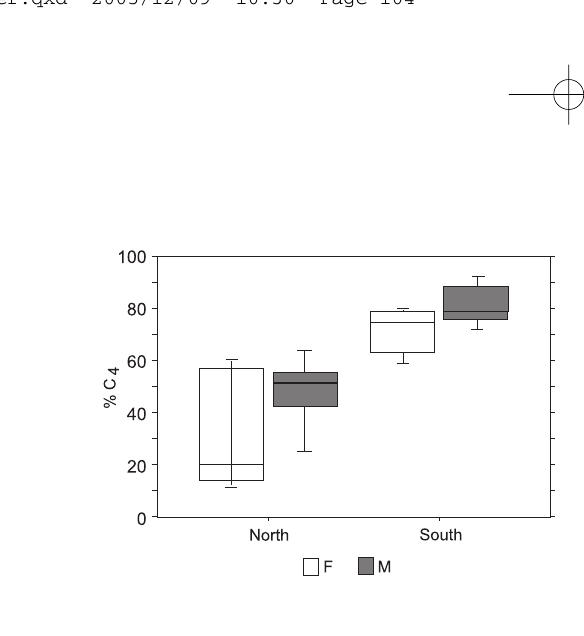
Fig. 3. Boxplot with the median, 25–75 %, and stan- dard deviation of the dietary percentage of C 4 grass consumed by male and female impala in the Kruger National Park. Males clearly graze more than females throughout the park, although the difference is only significant in the